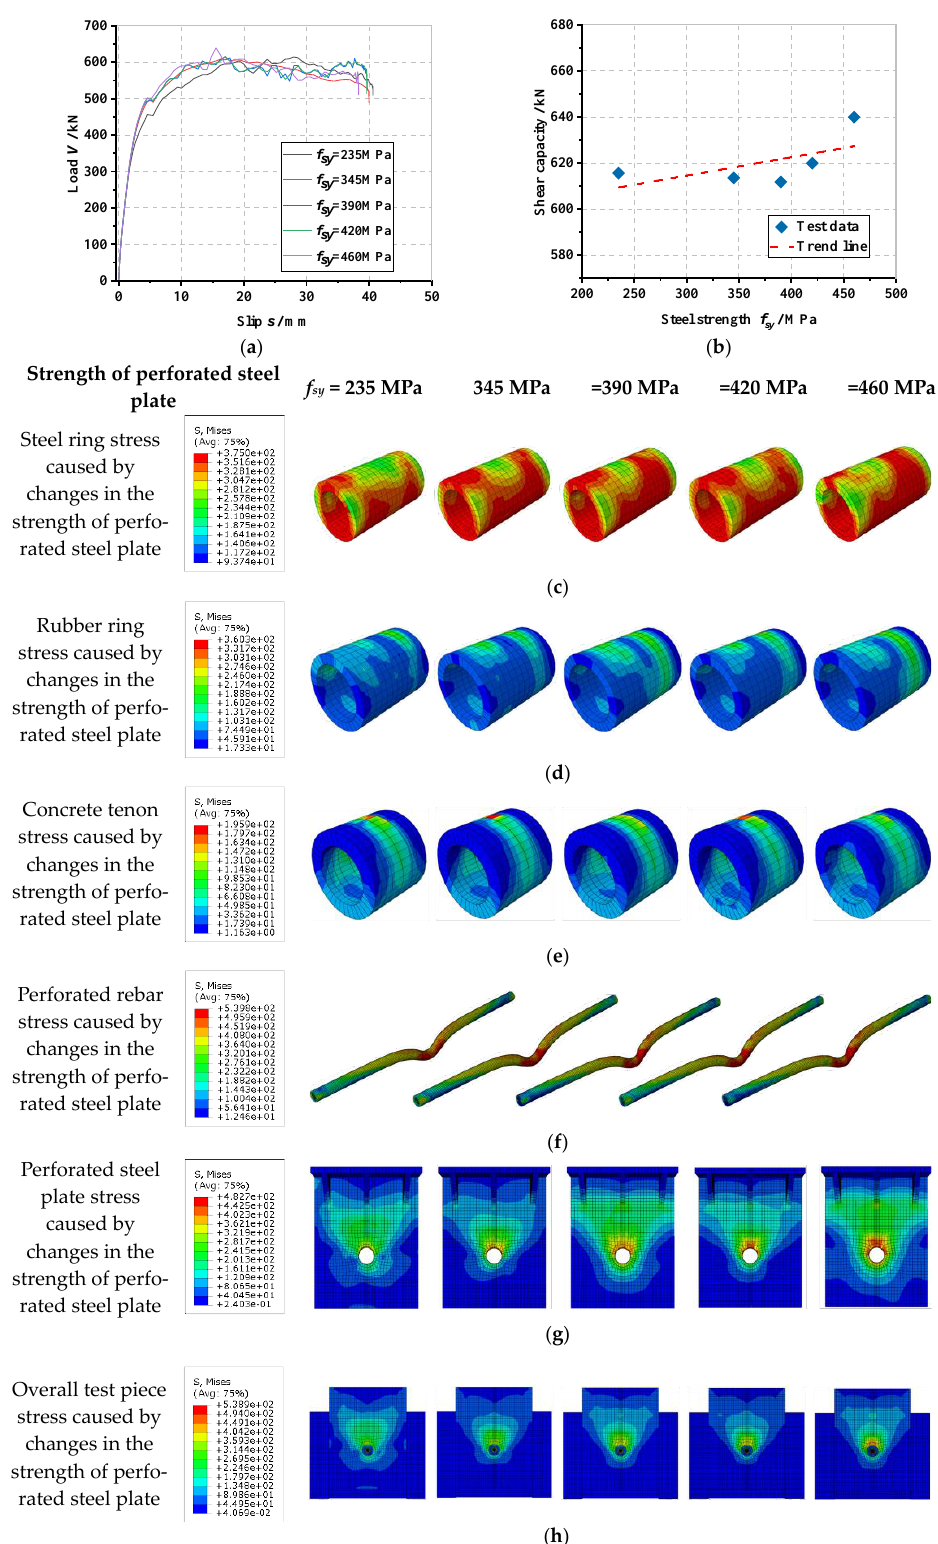
Figure 14. Influence of perforated steel plate strength: ( a ) overall load – slip curves, ( b ) impact analysis, ( c ) steel ring stress, ( d ) rubber ring stress, ( e ) concrete tenon stress, ( f ) perforated rebar stress, ( g ) perforated steel plate stress, ( h ) overall stress in the specimen.